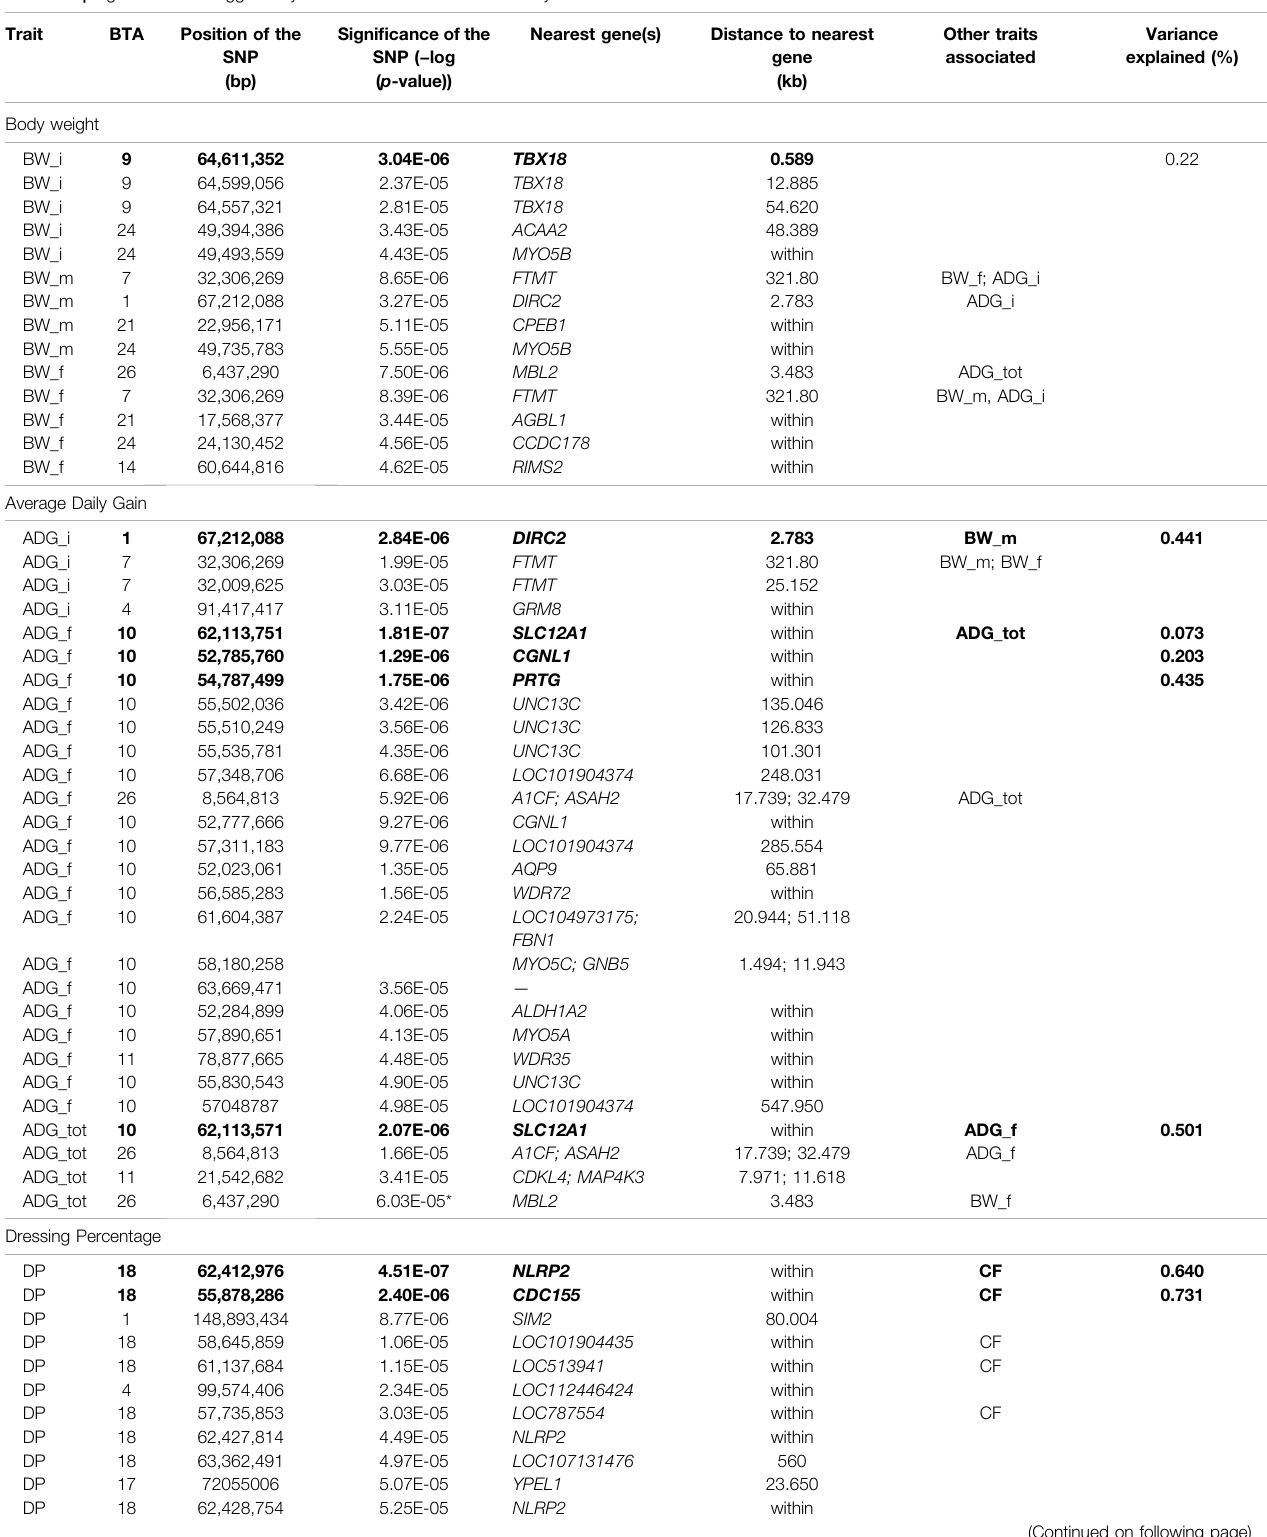
TABLE 3 | Signi fi cant and suggestively SNPs found on the GWAS study.